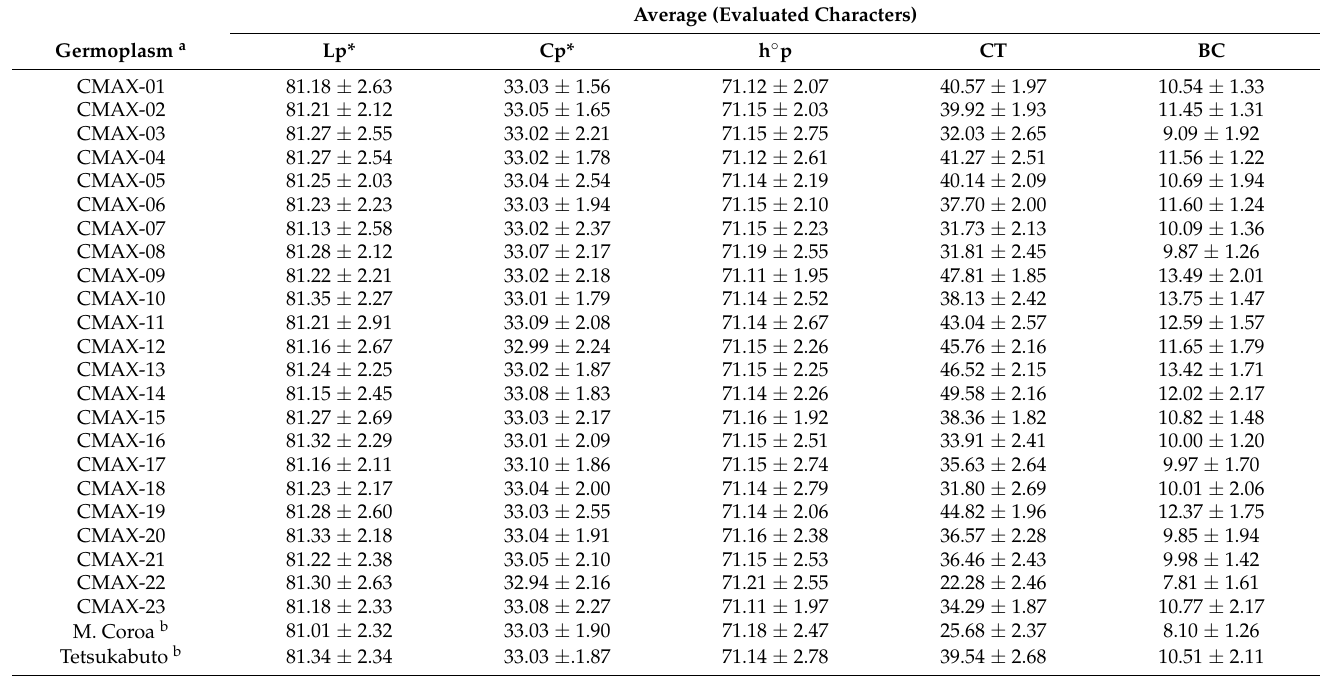
Table 3. Means and standard deviations of color descriptors, total carotenoids, and β -carotene. Mossor ó -RN, 2020.